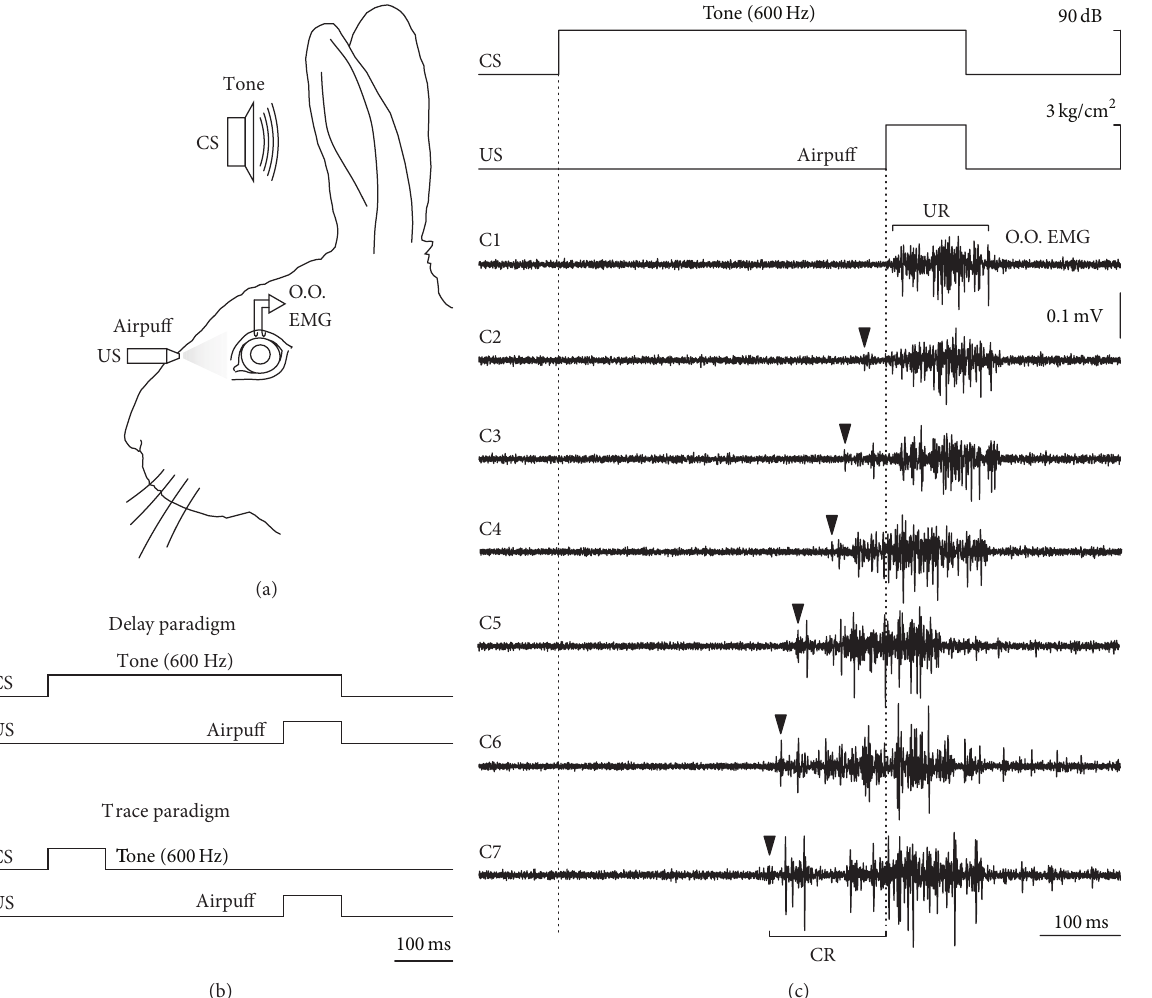
Figure 5: Eyeblink conditioning protocols and electrophysiological recording of the conditioned eyelid response. (a) Experimental design for eyeblink conditioning in behaving rabbits illustrating the location of the bipolar hook electrodes for the recording of orbicularis oculi muscle activity (O.O. EMG). Classical eyeblink conditioning protocol consists of pairing a conditioned stimulus (CSt) (e.g., a neutral stimulus such as a tone) and an unconditioned stimulus (USt) (e.g., an airpuff to the eye that induces a reflexive blink). (b) Two principal paradigms have been classically used depending on the temporal relationship between CSt and USt. Thus, in the delay paradigm (top) the CSt and USt coterminate. In the trace paradigm there is a constant time interval between both stimuli (bottom). (c) The figure illustrates the eyeblink conditioning process using a delay paradigm. The conditioning paradigm (CS and US presentations) and representative orbicularis oculi electromyohraphic (O.O. EMG) recordings from the same animals along seven conditioning sessions (C1–C7) are presented. Along conditioning sessions the initial unconditioned response (UR), consisting of a reflexive eyelid response just after the US, leads to a timed eyelid response which precedes the USt named the conditioned response, CR